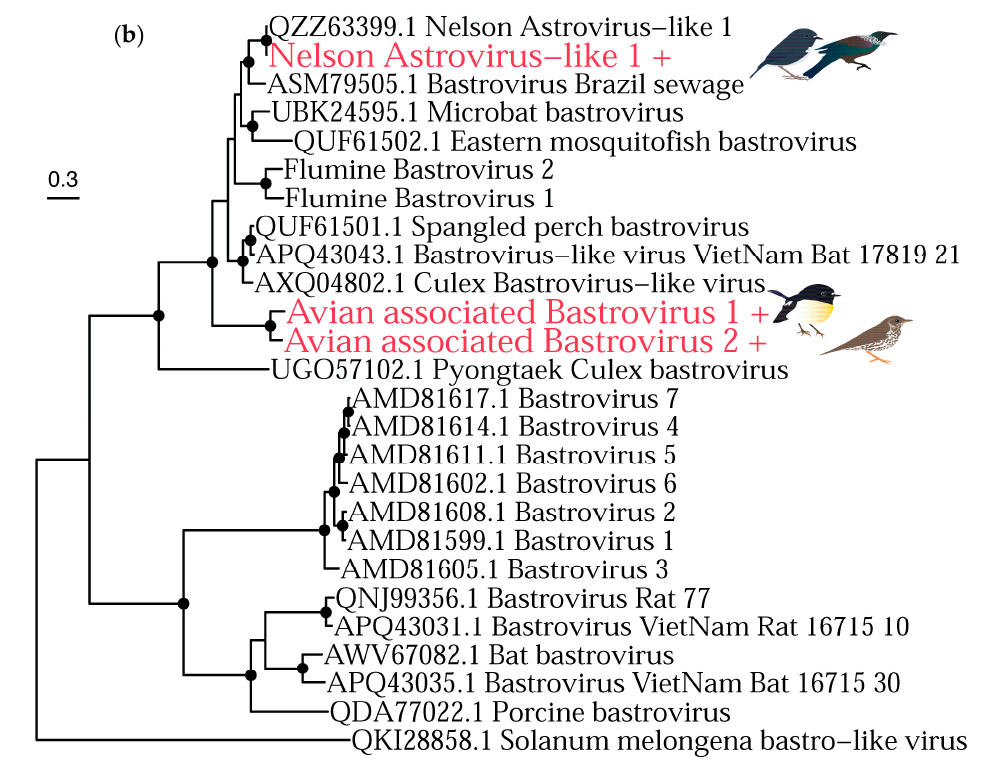
Figure 7. ( a ) Phylogeny of the Astroviridae, alignment length of 1306 amino acids. ( b ) Phylogeny of the bastrovirus clade, alignment length of 1305 amino acids. Both phylogenies are based on the RNA polymerase gene. Colours and symbols as shown in Figure